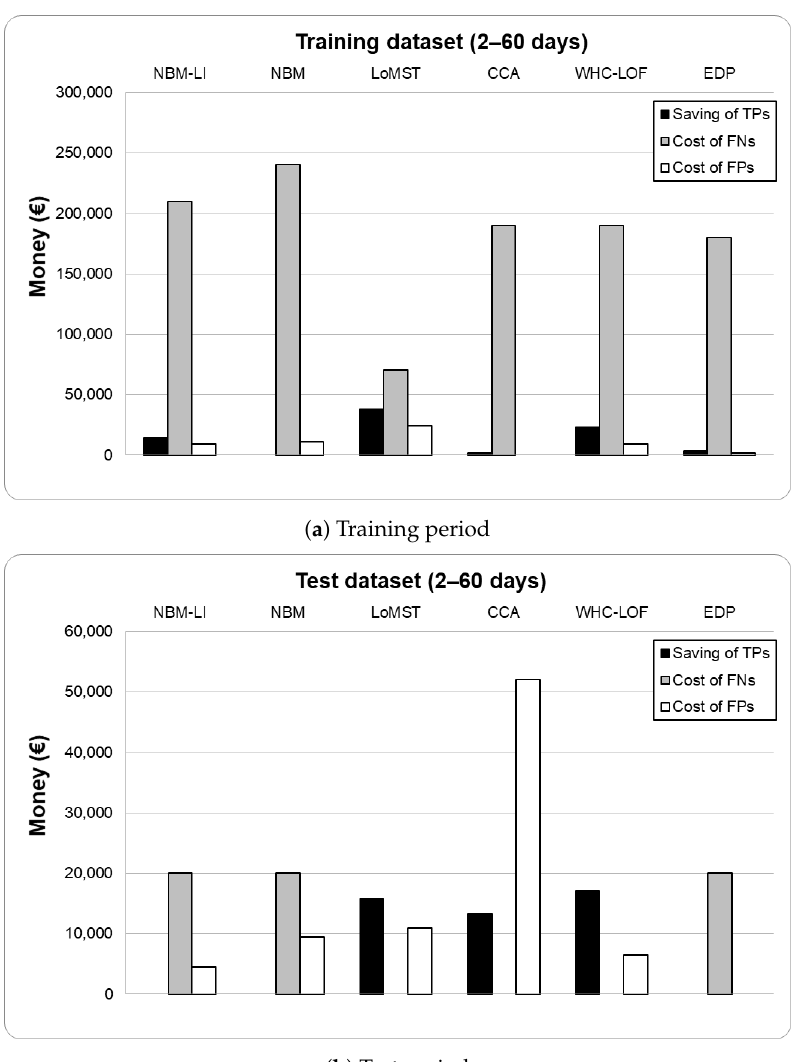
Figure 12. Savings and costs due to different fault type for each model, EDP evaluation method (2–60